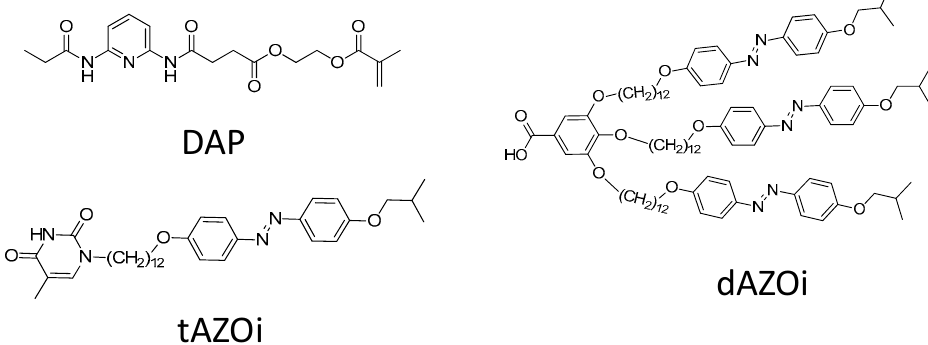
Figure 1. Molecular components in this study: dAZOi: Azo-dendron with benzoic acid termination; tAZOi: linear azo-compound with thymine head; DAP: the diacylaminopyridine monomer.